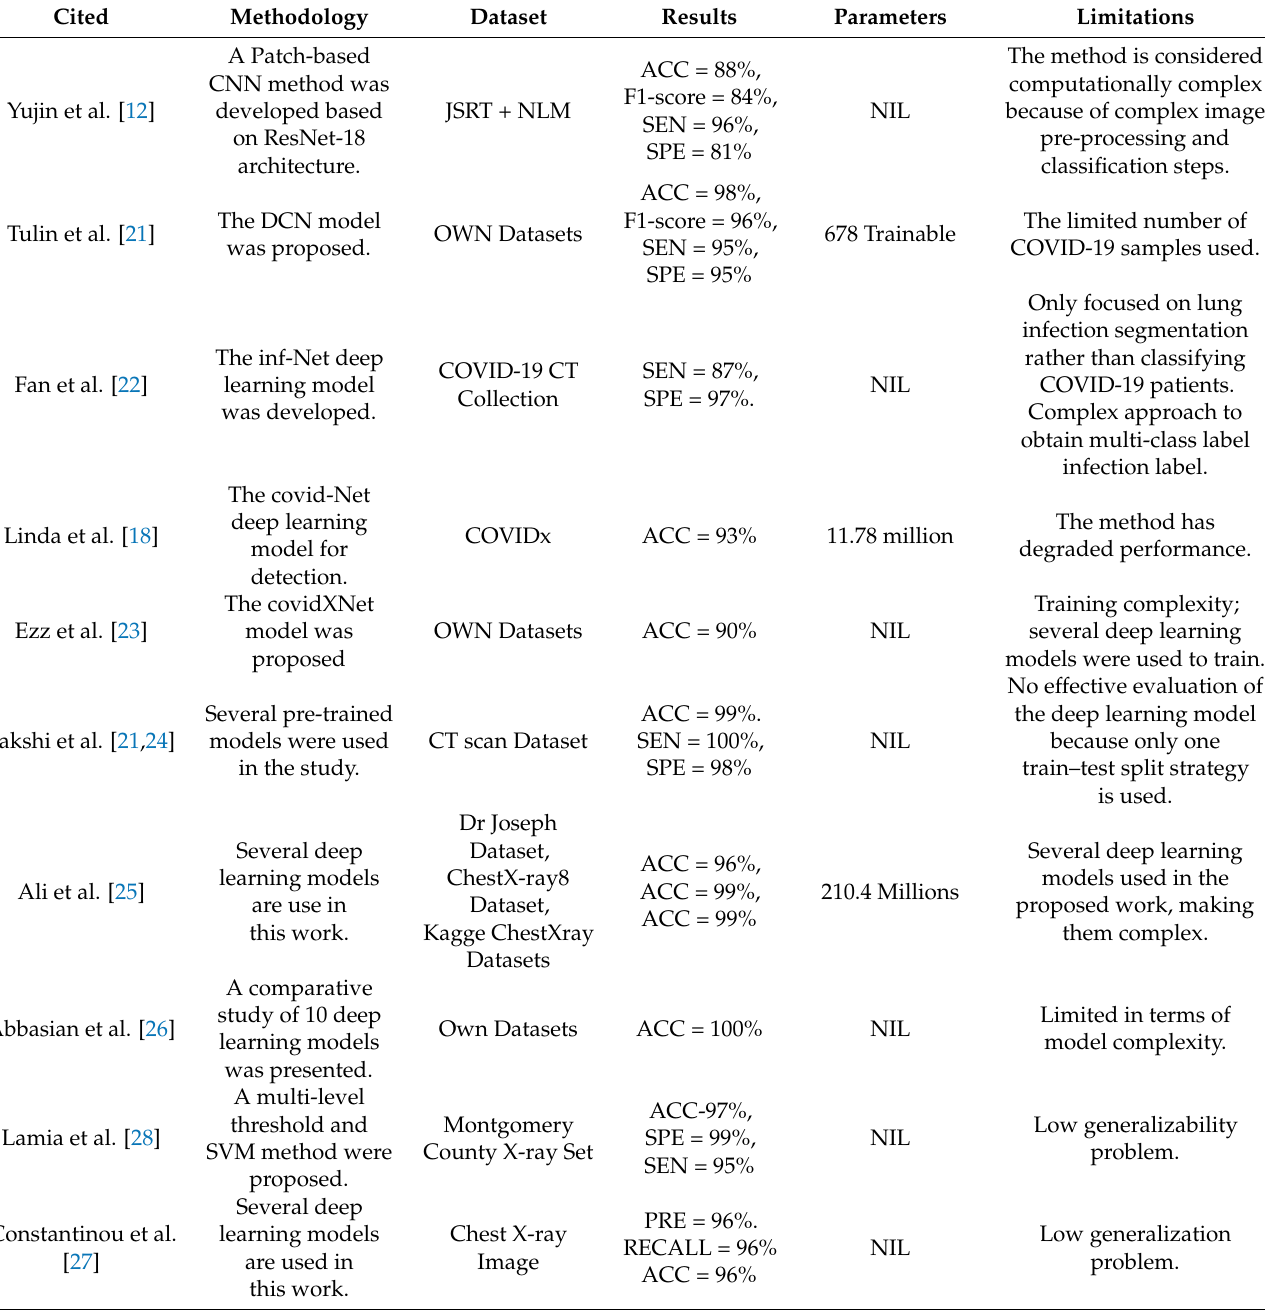
Table 1. Summary of related work for COVID-19